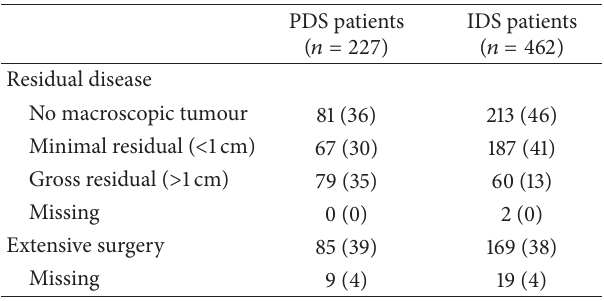
Table 2: Treatment results according to treatment group. Values given are numbers